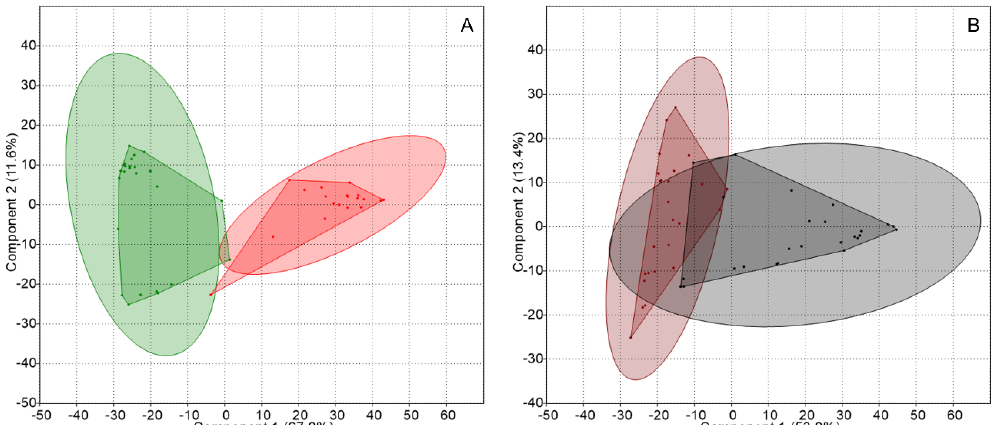
Figure 2. PCA of the genetic structure of the nitrogen-fixing guild associated with thalli and substrates: ( A ) Peltigera thalli (green) and Cladonia thalli (red), and ( B ) Peltigera substrates (brown) and Cladonia substrates (gray). Concentration ellipses (ovals surrounding the convex hulls) estimate the region where 95% of population points are expected to fall.